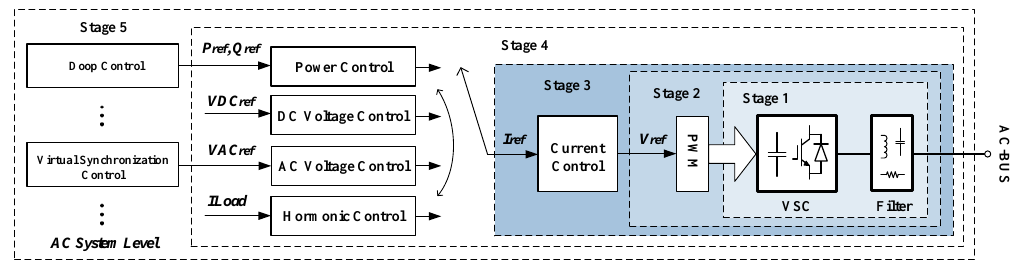
Figure 3. Unified diagram of the stability problem in various application fields.